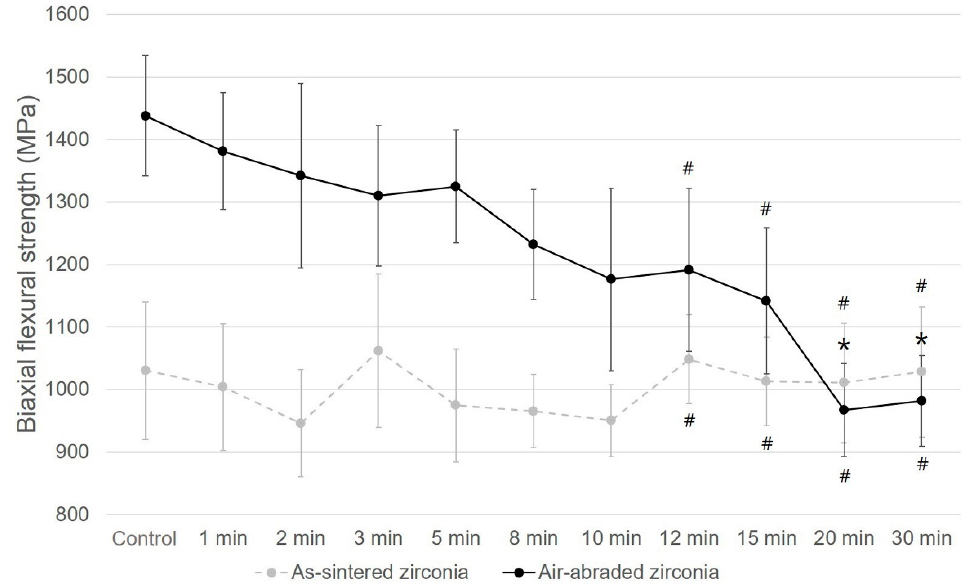
Figure 4. Biaxial flexural strength (mean ± standard deviation) of as-sintered and air-abraded zirconia in accordance with etching time ( n = 10 per timepoint, MPa). The asterisk indicates significance compared to the control specimen of air-abraded zirconia ( p < 0.05). The as-sintered zirconia group showed no significant difference in biaxial flexural strength with etching time ( p > 0.05). The pound symbol indicates no significant difference between the as-sintered and air-abraded zirconia samples at the same etching time ( p > 0.05). Table 3. Mean and standard deviation of flexural strength and Weibull parameters of as-sintered and air-abraded zirconia specimens according to etching treatment time.